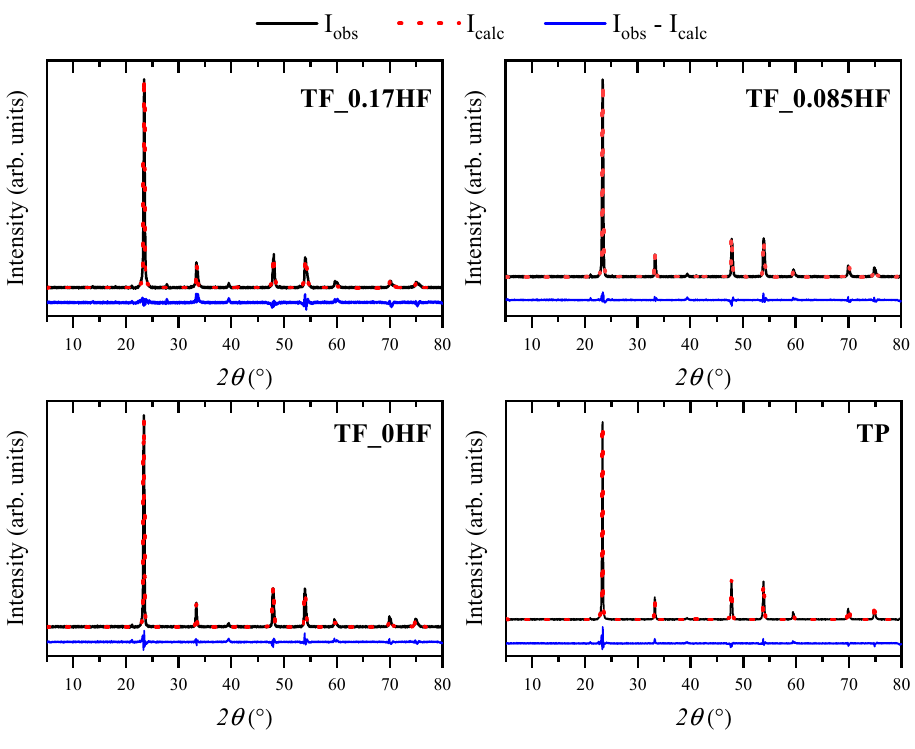
Figure 1. XRD patterns of synthesized TiOF 2 samples. Table 2. Lattice and microstructural parameters of TiOF 2 obtained by XRD, BET and EDS